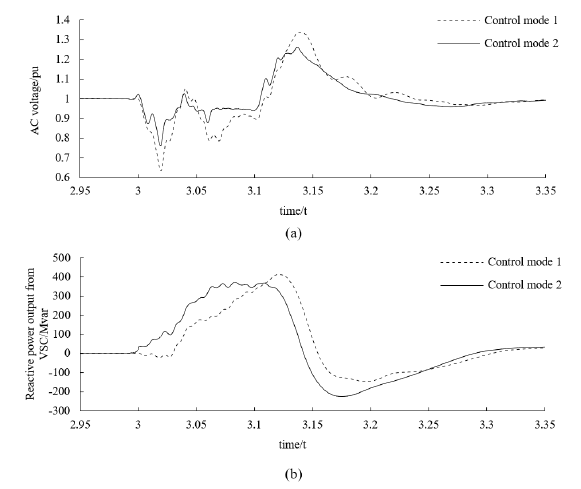
Fig. 10. Simulation comparison diagram of fault lasting for